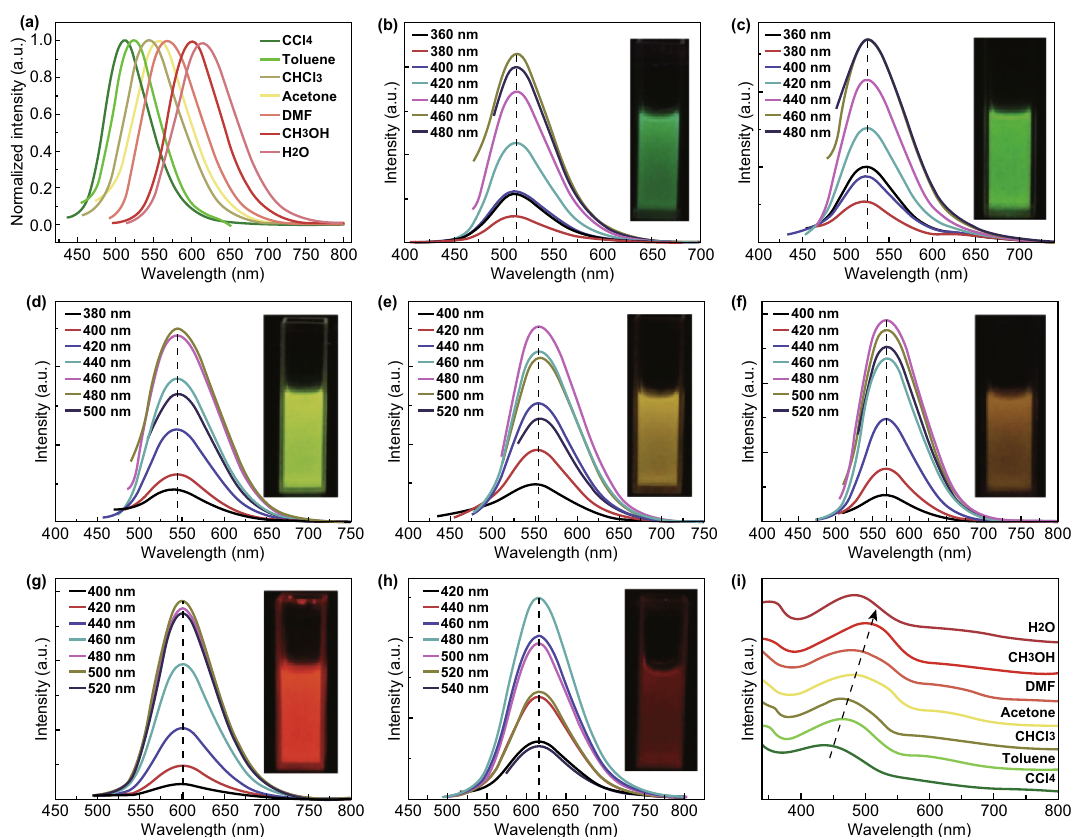
Fig. 6 PL spectra of CDs prepared from p -phenylenediamine dispersed in different solvents. CDs dispersed in a tetrachloromethane, b toluene, c chloroform, d acetone, e dimethyl formamide, f ethanol, and g water, and h absorption spectra of the CDs in different solvents [76]. Copyright (cid:2) 2017 The Royal Society of